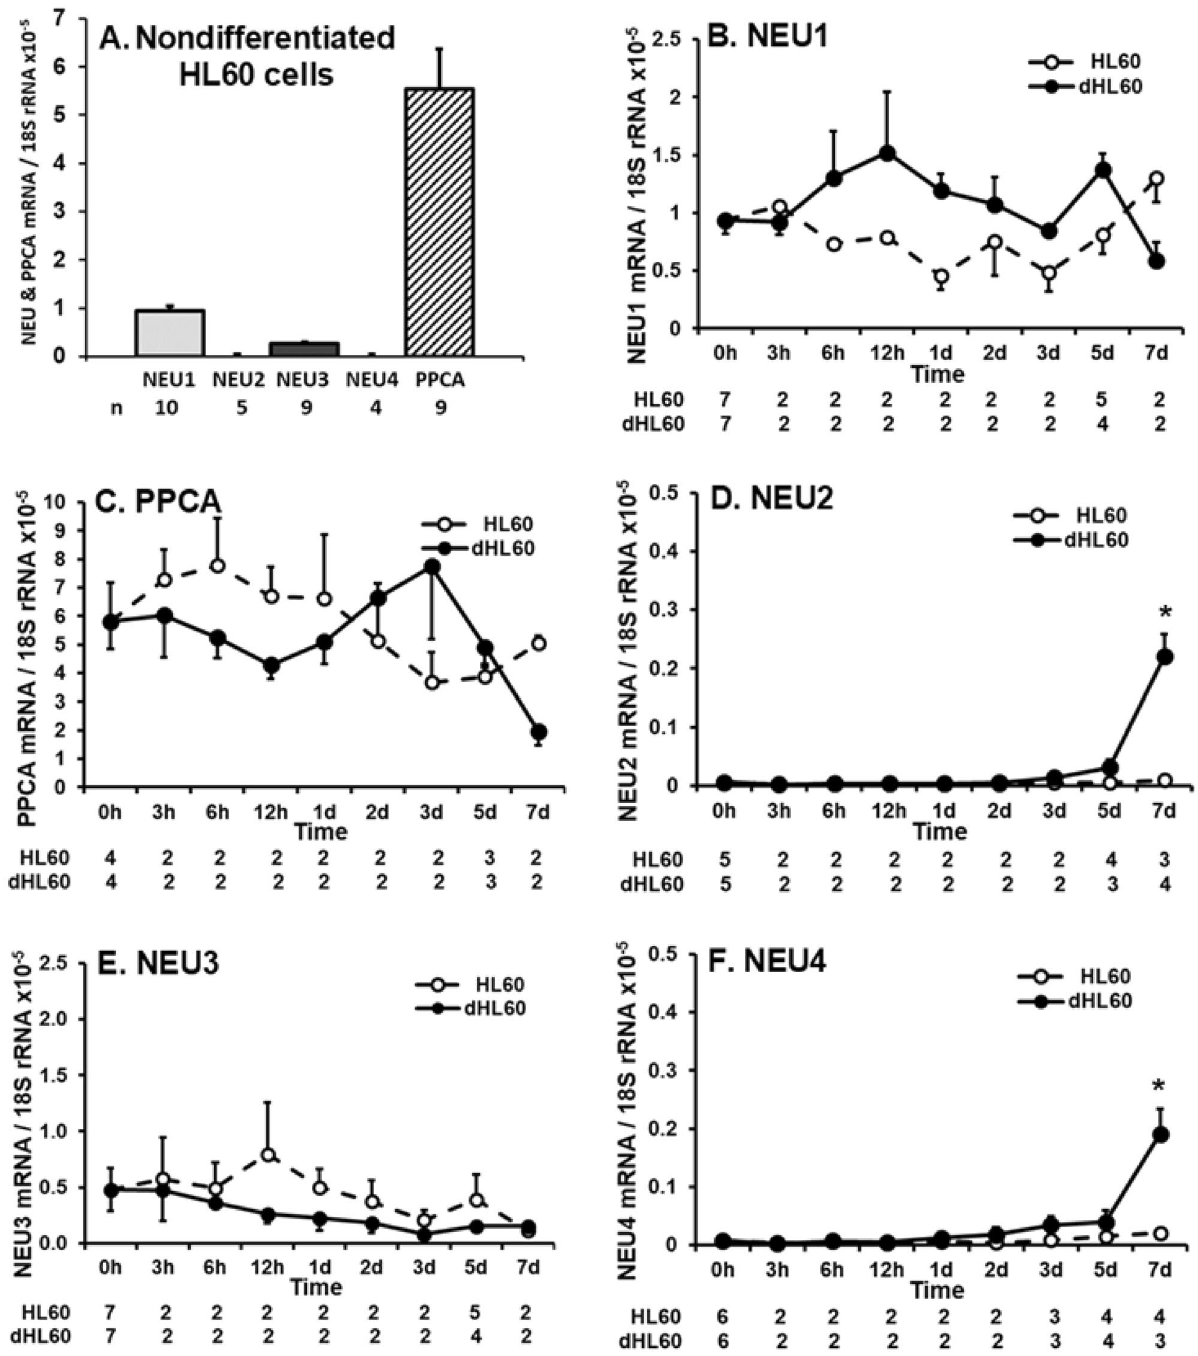
Figure 4. NEU and PPCA Gene Expression During HL60 Cell Differentiation. ( A ) Total RNA isolated from nondifferentiated HL60 cells was processed for qRT-PCR for mRNA levels for NEU1-4 and PPCA, and normalized to the 18S rRNA control. ( B – F ) Total RNA isolated from HL60 cells cultured for increasing times in the presence of DMF or medium alone was processed for qRT-PCR to quantify mRNA levels for NEU1 ( B ), PPCA ( C ), NEU2 ( D ), NEU3 ( E ), and NEU4 ( F ), and each normalized to the 18S rRNA control. The n for each data point is indicated below each vertical bar ( A ) or time point ( B – F ). Each vertical bar ( A ) or symbol ( B – F ) represents mean ± SE normalized mRNA levels. The data generated in each panel represents experiments performed on ≥ 2 independent occasions. *, increased normalized NEU2/4 mRNA expression compared to nondifferentiated cells at p <